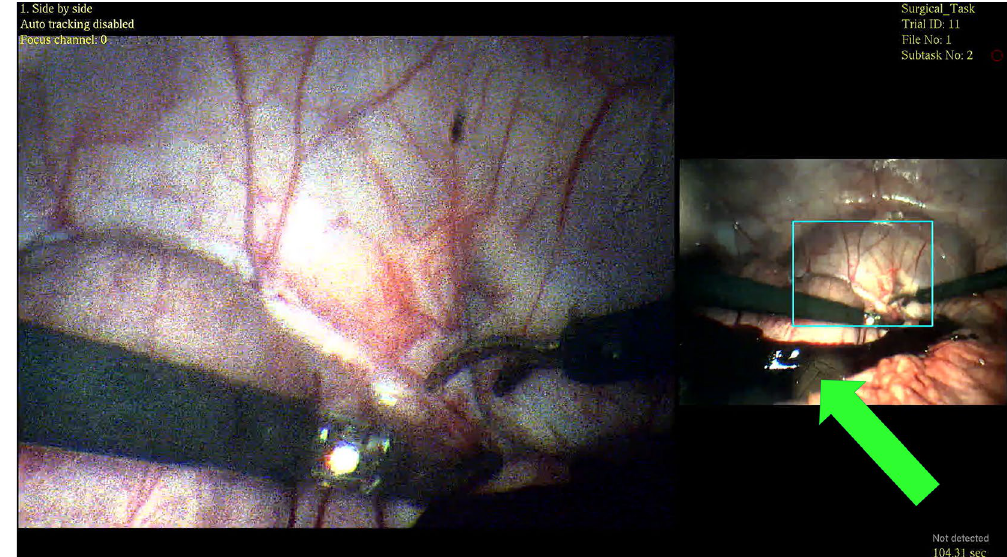
Figure 8. An image captured during in-vivo testing of the MRFL. Blood pooling from periphery is highly visible and easily seen in the wide view (green arrow) but not in the zoomed view. The dual-imaging nature of the MRFL allows for efficient visualization, prevention, and mitigation of adverse events in the field periphery.